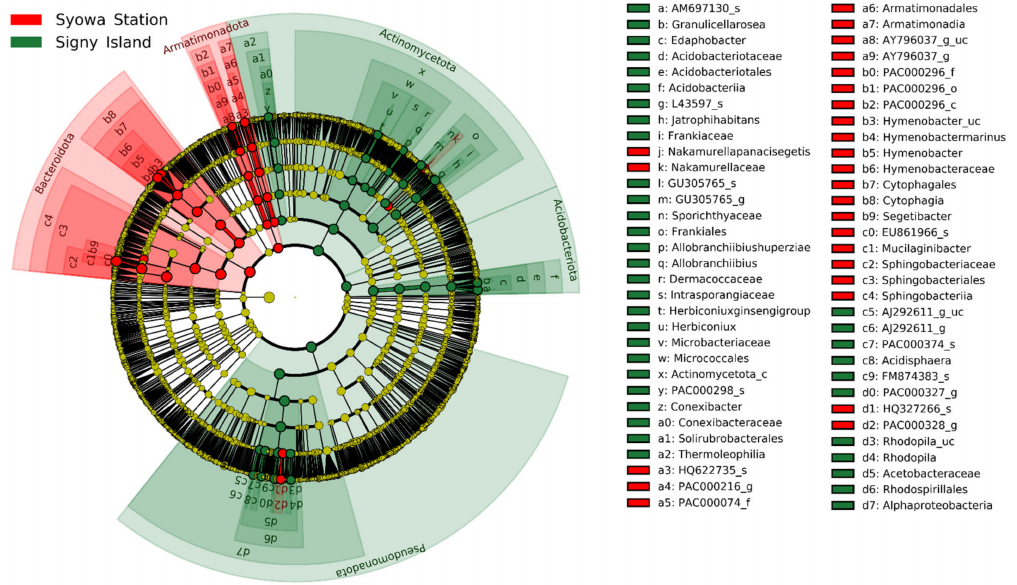
Figure 4. LEfSe cladogram showing taxonomic biomarkers of bacteria associated with the lichens collected from Signy Island (green) and the Syowa Station region (red). The innermost node corre- sponds to the domain Bacteria, followed by concentrically arranged nodes of phylum, class, order, family, genus and species. Red and green nodes/shades indicate taxa that are significantly higher in relative abundance. Diameter of each node circle is proportional to abundance of the